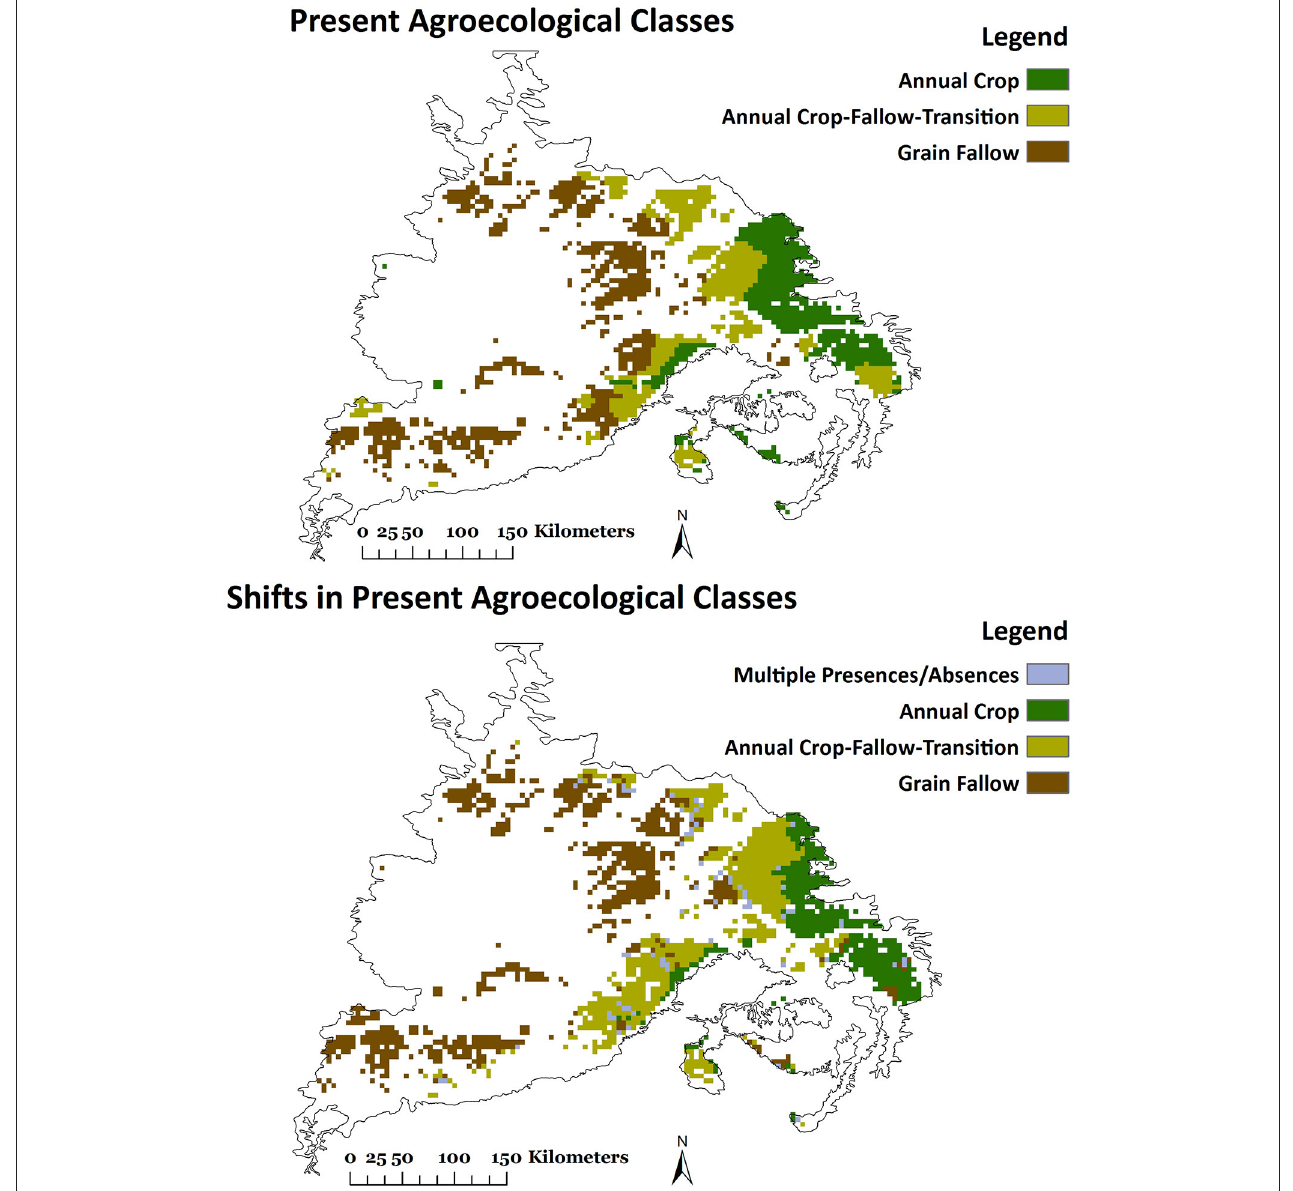
FIGURE 4 | Projected geo-spatial distribution of three agro-ecological classes (AECs) using three individual Random Forest (RF) models of bioclimatic variables under future climate scenario (2070, Representative Concentration Pathway,